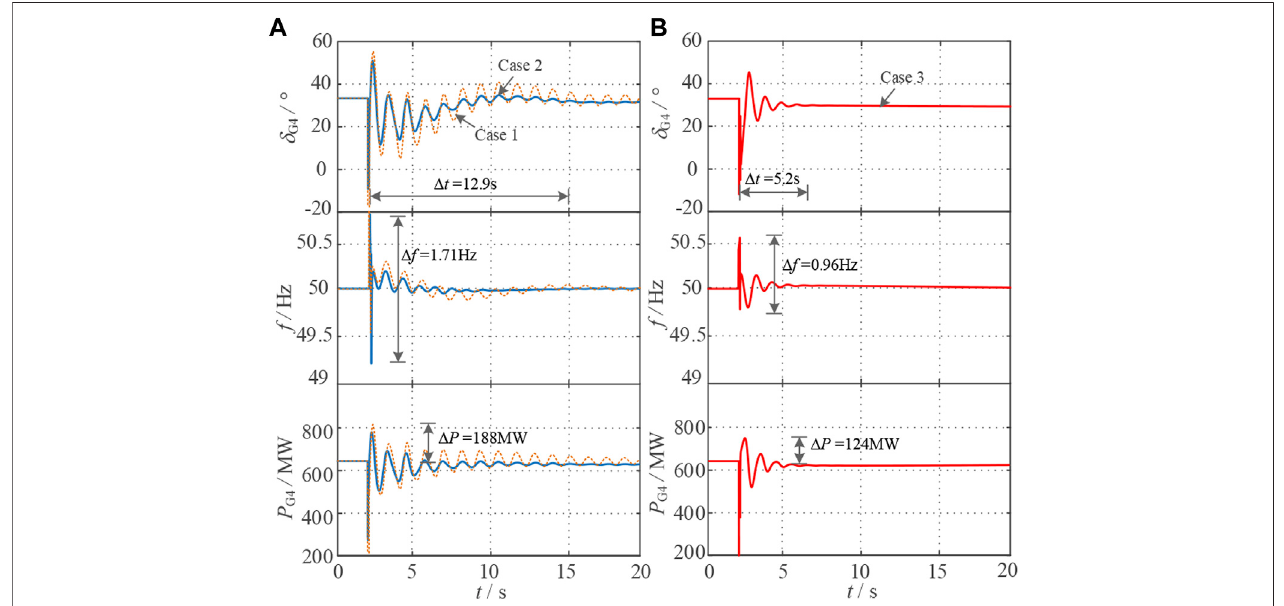
FIGURE 6 | Figure shows the dynamic response curve of the system under short-circuit fault, in which no control is applied to the wind turbine in case 1, the traditionalconstantinertiacontrolisappliedtothewindturbineincase2,andtheoptimalcontrolproposedinthispaperisappliedtothewindturbineincase3.Inorderto highlight the contrast effect, the response curves under case 1 and 2 are drawn as (A) , and the response curves under case 3 are drawn as (B) .